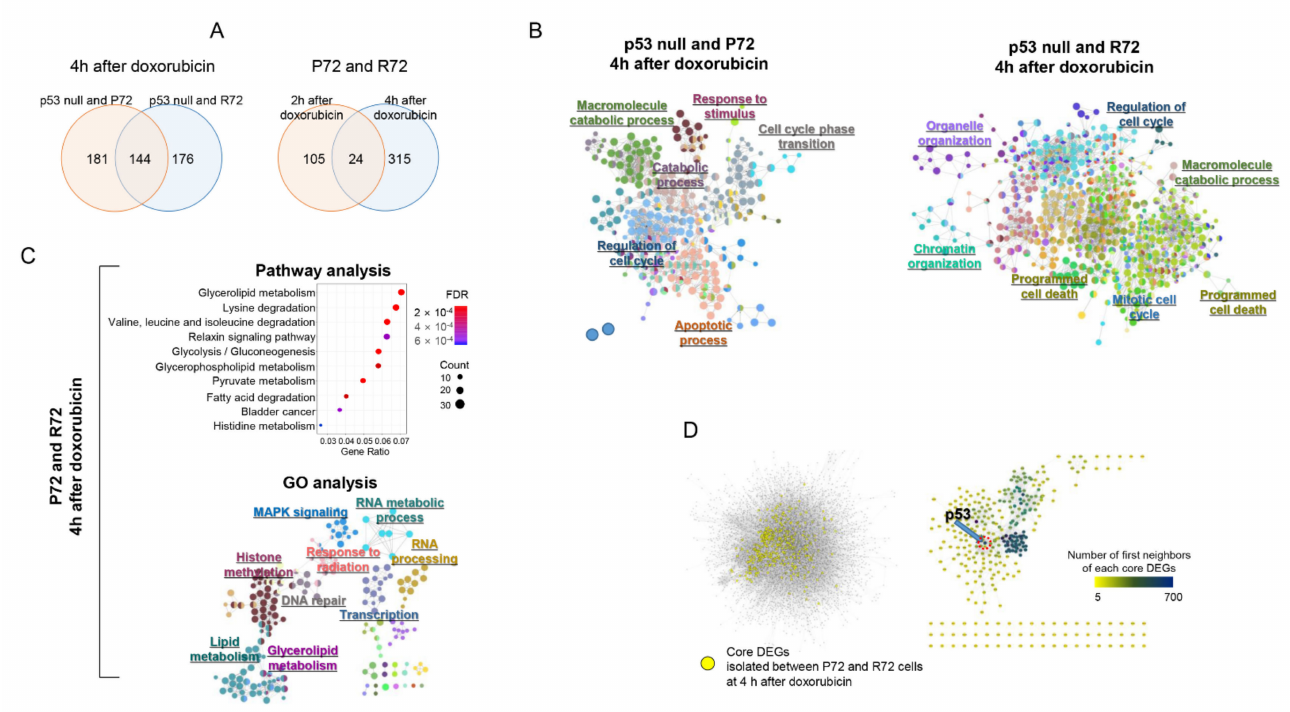
Figure 4. Functional difference among P72, R72, and p53 null cells. ( A ) After selecting the core DEGs from each of P72, R72, and p53 null cells, their distributions were compared. ( B ) The association of core DEGs between P72 (or R72) and p53 null cells with GO-term was measured using the ClueGO program to make a GO-term network. Each node represents a GO term, and the node size is proportional to the number of genes associated with the GO-term. Closely related GO-terms are marked with the same color. Representative GO-terms are highlighted. ( C ) Functional associations of core DEGs between P72 and R72 cells were measured in pathway (upper panel) and GO-term enrichment assays (lower panel). In the pathway analysis (upper panel), the distribution of false discovery rate (FDR) values of each pathway and the number of genes included in the pathway were shown according to the ratio of genes included in the pathway. In the GO-term analysis (lower panel), the ClueGO program was used to construct an enriched GO-term network. ( D ) The location of each core DEG between the P72 and R72 cells was marked in the interaction network. Directly connected core DEGs were indicated in the right panel, and the color of the nodes indicates the number of nodes connected to each node, as shown in scale bar. The positon of p53 genes was